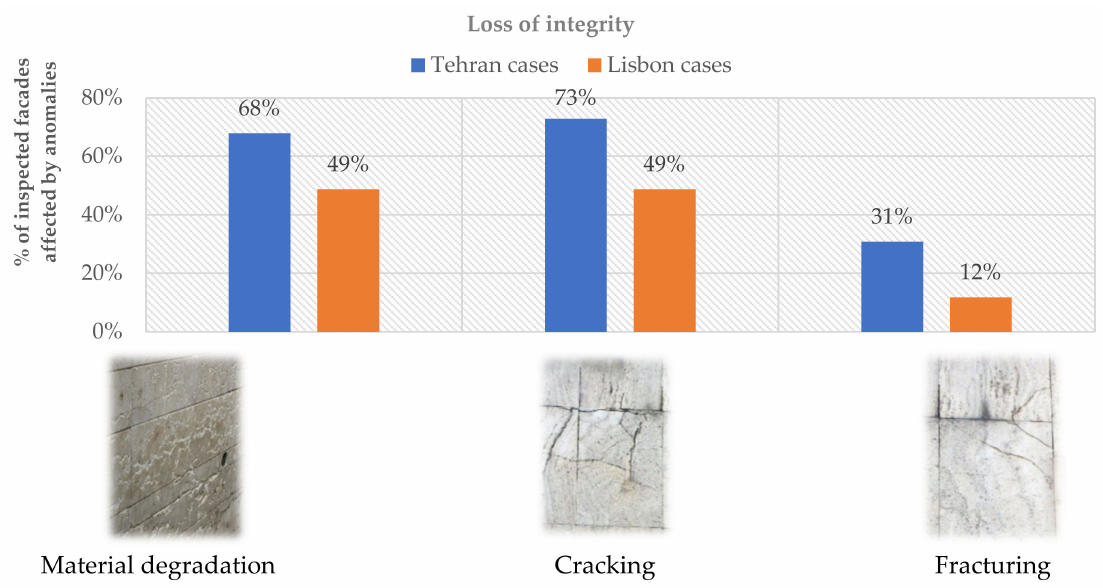
Figure 7. Frequency of the different loss of integrity defects in the samples under